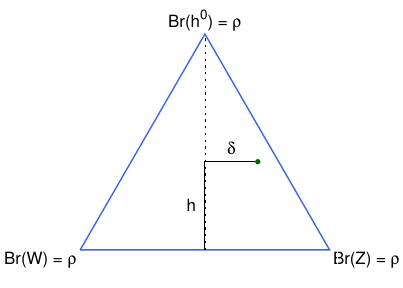
Figure 7 . Coordinates used to parameterise branching ratios in a